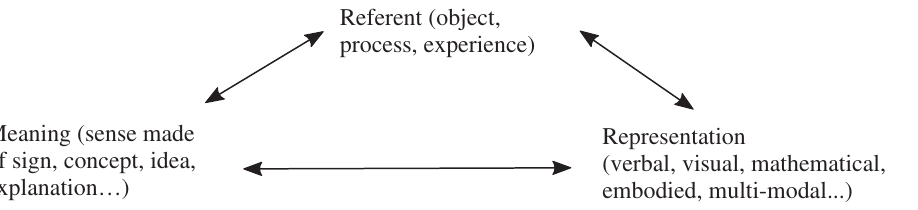
FIG. 1. Tripartite relation of referent (object), representation, and meaning (interpretation), or “ triangle of meaning ” ; see text (according to Refs.